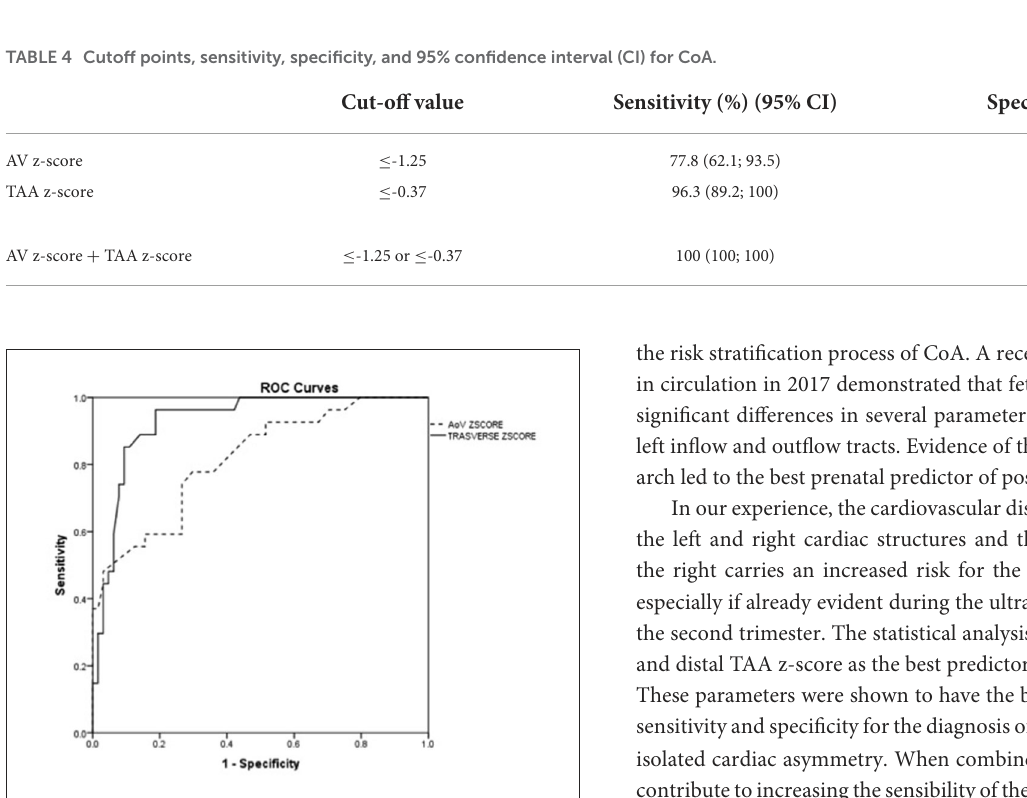
FIGURE5 The receiver operating characteristic curve of the z-score aortic valve annulus and the z-score distal transverse aortic arch z-score at the third-trimester